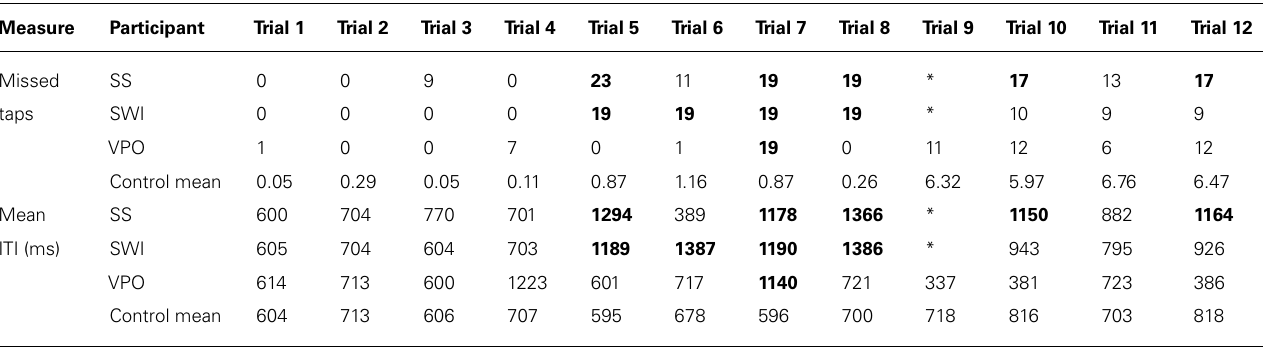
Table 3 | Number of missed beats and mean ITIs in the dysrhythmic participants compared to the control group. Measure